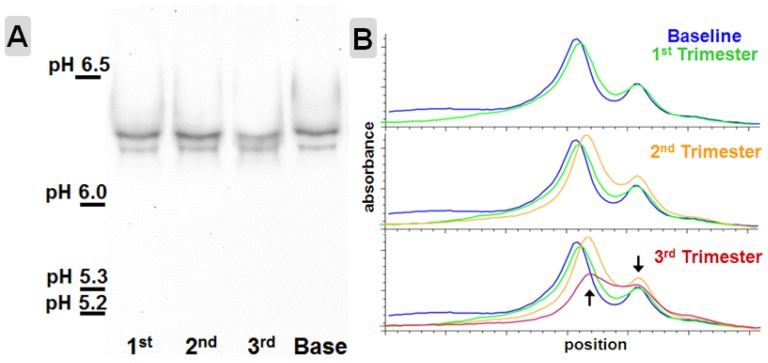
Shift in isoelectric focus (IEF) pattern in pregnancy.
A. A normalized plasma isoelectric focusing gel from the same pregnancy as shown in Figs 3 and 4 immunoblotted for VWF. B. Densitometry tracings demonstrate the progressive shift in VWF isolectric focus in the 2nd (orange) and 3rd (red) trimesters. In the 3rd trimester, the band volume ratio of VWF in the doublet has shifted (3∶1 to nearly 2∶1) and the upper VWF band has shifted towards the lower pH focused VWF band.